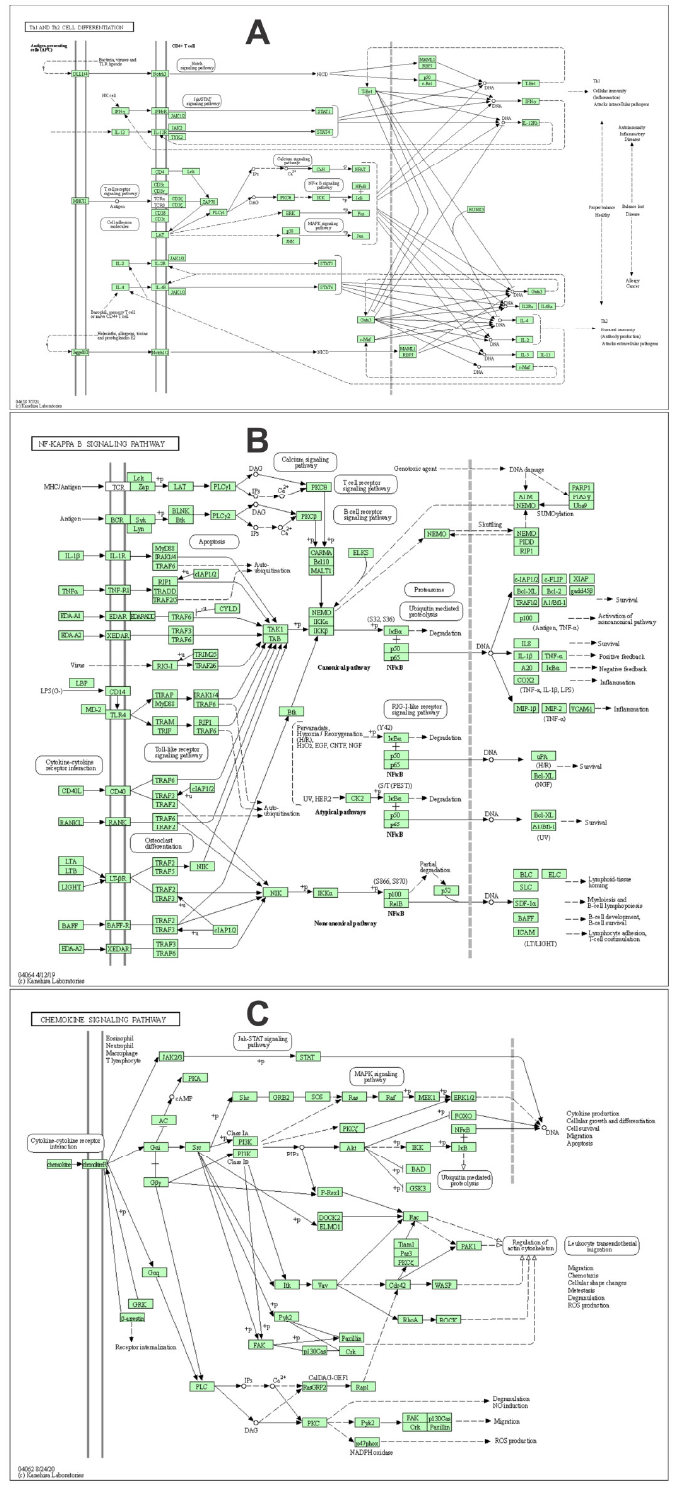
Figure 5. Pathways of the innate and adaptative immune system that contain genes that were differentially expressed by the acute physical exercise in horses. ( A ) The Th1 and Th2 cell differentiation signaling pathways, which are mainly driven by cytokines IL2 and IL4, respectively. ( B ) The NF-kappa B signaling pathway, which is considered as a regulator of innate immunity and links pathogenic signals and cellular danger signals, thus organizing cellular resistance to invading pathogens. ( C ) The chemokine signaling pathway, which is associated with the activation, differentiation, and migration of immune cells [13].